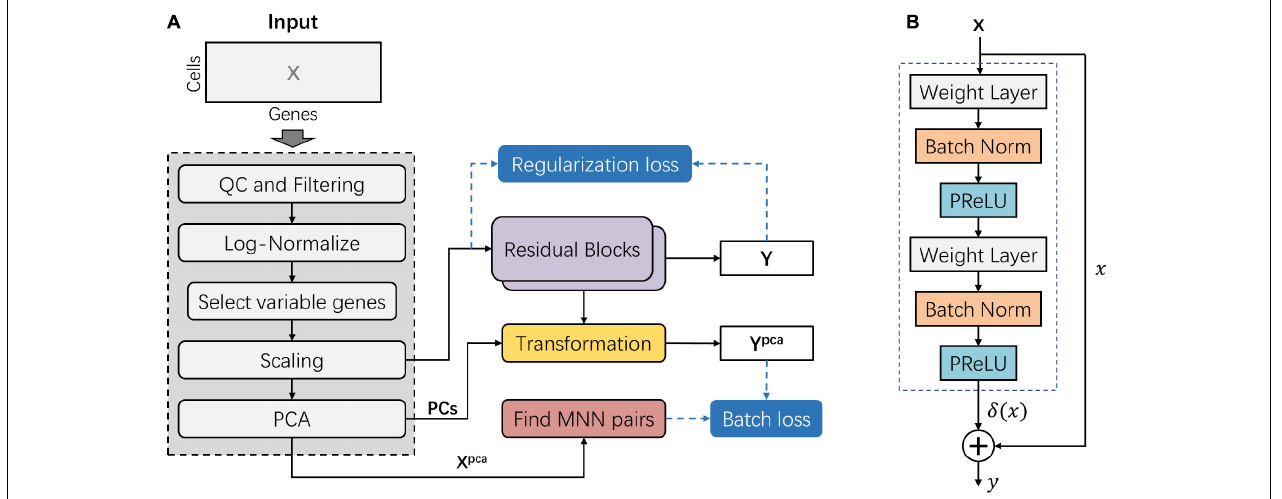
FIGURE 1 | Overview of the deepMNN framework. (A) Illustration of the deepMNN workflow that was comprised of data pre-processing, principal component analysis transformation, mutual nearest neighbor pair search, batch correction network with a stack of two residual blocks, and calculation of batch loss and regularization loss. (B) Residual block comprised of two sequences of three consecutive layers, including the weight layer, batch normalization layer, and PReLU activation layer.